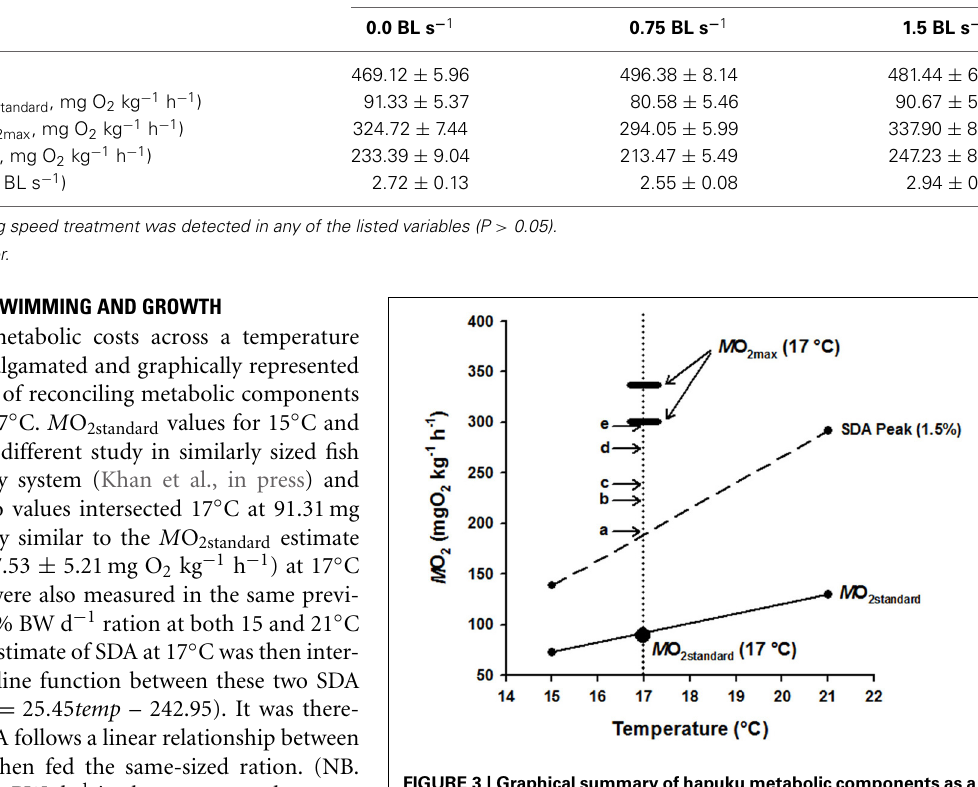
FIGURE 3 | Graphical summary of hapuku metabolic components as a function of temperature (15–21 ◦ C) with particular detail at 17 ◦ C, allowingthecostsofspecificdynamicaction(SDA)andswimmingtobe balanced within the boundaries of aerobic metabolic scope (AMS = M O 2max - M O 2standard ). M O 2standard atandbetween15and21 ◦ C(smallfilled circles adjoined by the lowest solid line) was taken from Khan et al. (in press) using a static respirometry system whilst M O 2standard at 17 ◦ C (large filled circle) was measured directly within the current study using the swim-flume respirometer.Thetwosmallfilledcirclesadjoinedbythebrokenlineshowthe peak in the SDA response of 300–500g hapuku fed a 1.5% BW d − 1 ration at and between 15 and 21 ◦ C (Khan et al., in press). It is likely that the SDA costs measured at 15 and 21 ◦ C can be used to accurately interpolate the feeding costsoffishinthecurrentstudyat17 ◦ Cbecausethefixed1.5%BWd − 1 ration of Khan et al. (in press) closely approximates the 1.3–1.8% BW d − 1 ad libitum ration level of fish from the different ER treatments. The thickened horizontal dash indicates the M O 2max of 300–500g hapuku measured in the swim flumeat17 ◦ Cduringthecurrentstudy.Overlaidabove M O 2standard (solidline) and peak SDA (broken line) are horizontal arrows with letters (a–e) showing theadditionalmeasuredcostsofswimmingfromthecurrentstudyat17 ◦ Cas follows: (a) 0.25 BL s − 1 , (b) 0.5 BL s − 1 , (c) 0.75 BL s − 1 , (d) 1.0 BL s − 1 , and (e) 1.5 BL s − 1 . The vertical dotted line therefore represents the transect through the accumulated costs of maintenance ( M O 2standard ), feeding/growth (SDA) and exercise of P. oxygeneios at 17 ◦ C and shows that the costs of SDA and